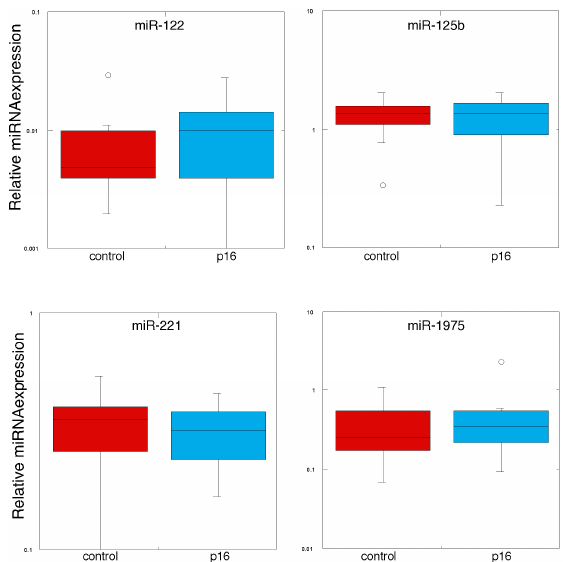
Figure 2. MiRNA expression in plasma ‐ derived exosomes from individuals with the p16 mutation and normal volunteers. RNA was prepared from plasma ‐ derived exosomes from individuals with the p16 mutation (CDKN2A:c.377T>A (p.V126D)) and normal volunteers. MiRNA expression was determined by qPCR ( n = 3) and normalized to the spiked ‐ in levels of Cel39.